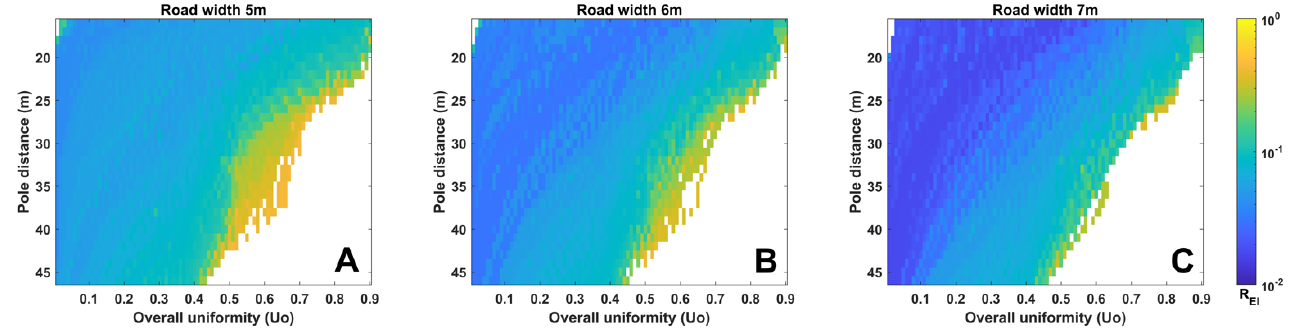
Figure 10. Overall uniformity of illuminance vs. pole distance vs. minimum R EI . Dark blue indicates a low R EI whereas yellowish refers to higher R EI levels. The white space equals a lack of technical solutions: ( A ) results for road width of 5 m; ( B ) results for road width of 6 m; ( C ) results for road width of 7 m.